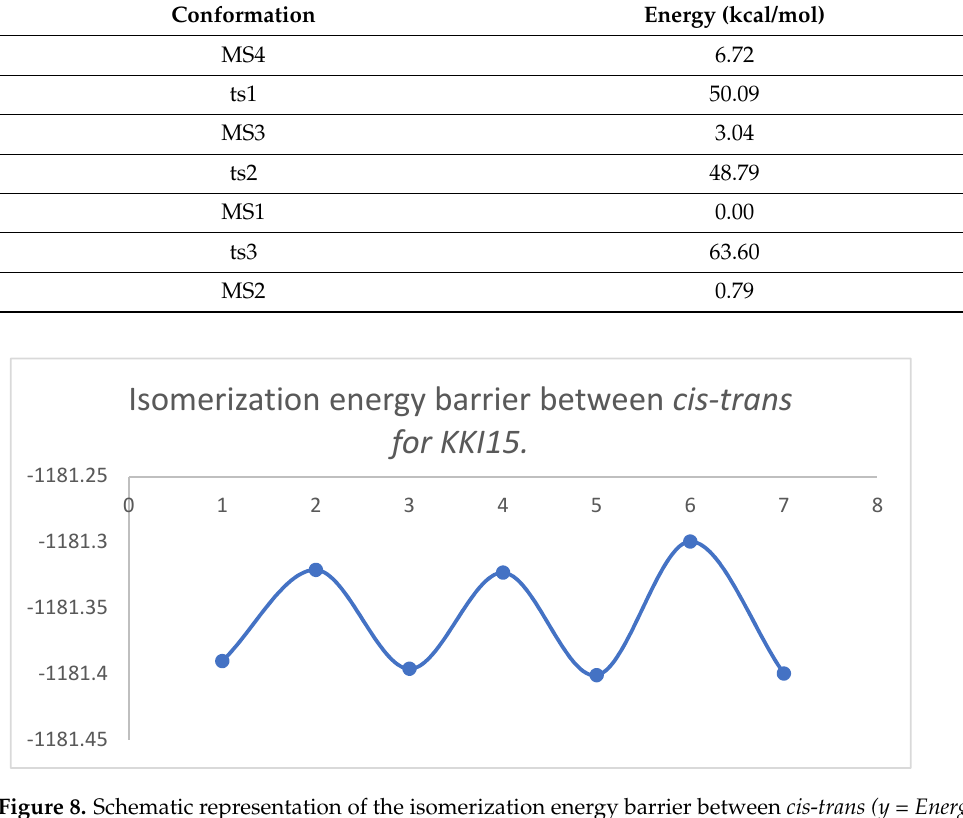
Table 4. Kinetic isomerization between cis-trans for KKI15 .